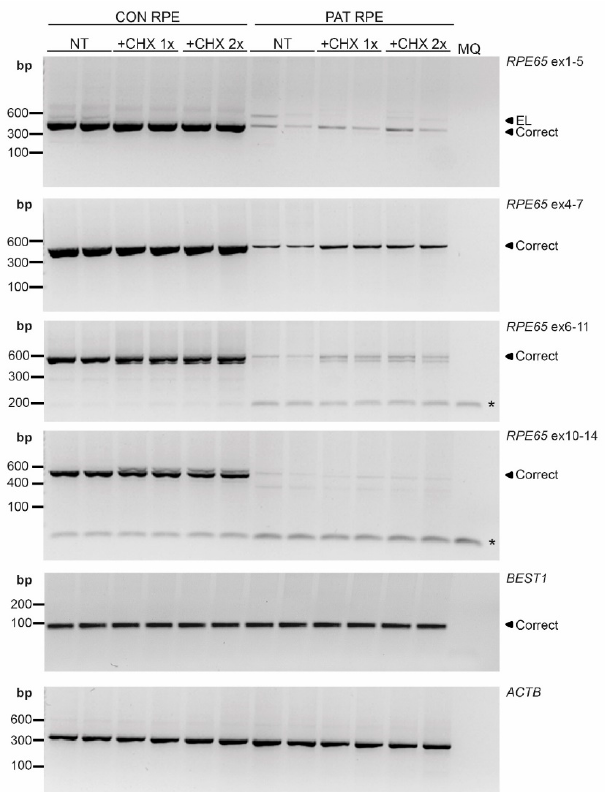
Figure 3. RT-PCR analysis in iPSC-derived RPE cells. Different regions of RPE65 were amplified in non-treated RPE cells (NT) and RPE cells upon treating the cells with the normal dose (+CHX 1×) or double dose (+CHX 2×) of cycloheximide for both the control (CON) and patient (PAT RPE cells. All amplicons showed RPE65 reduction in PAT RPE. * indicates primer dimers. BEST1 was used as RPE marker detection and ACTB was used as a loading control. MQ: milliQ water; EL: exon-elongation; correct: wild-type transcript; bp: base-pairs.